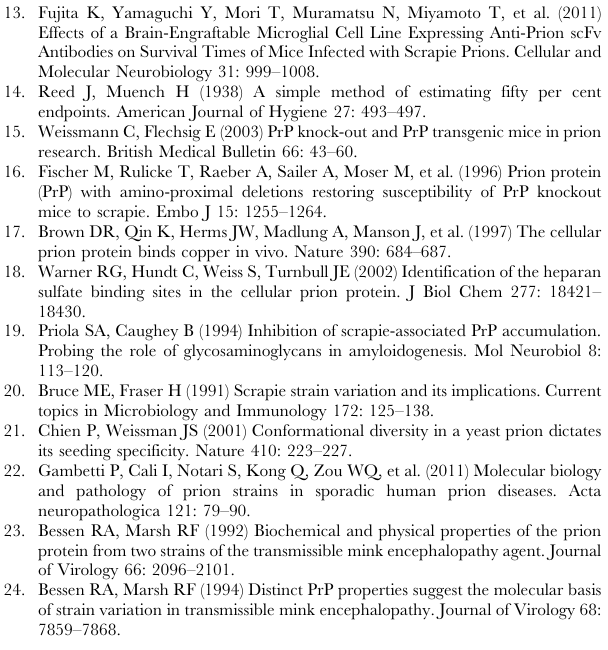
Table S1 Primers used in the present